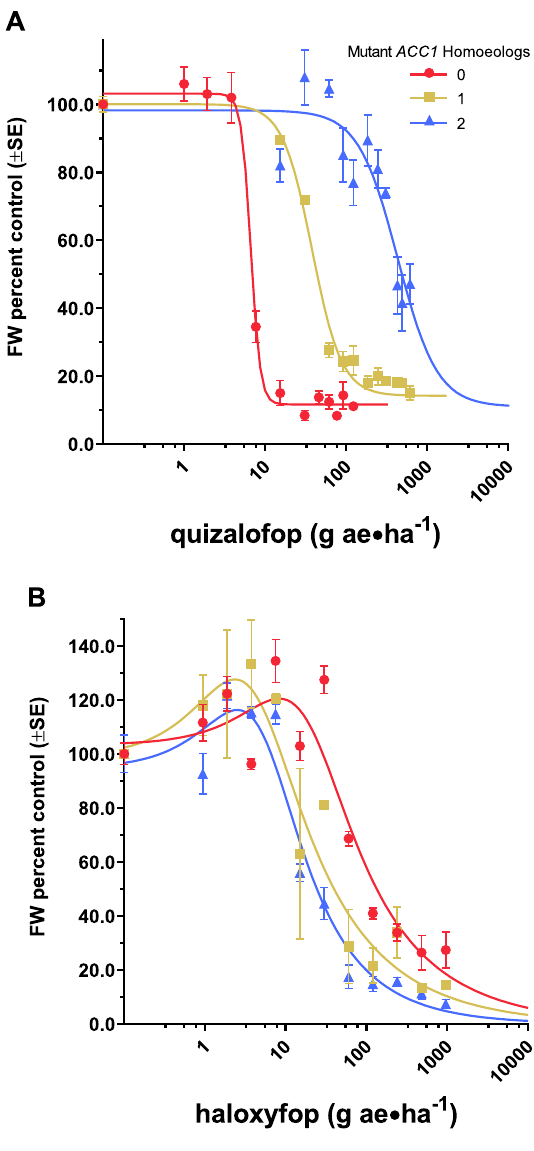
Figure 1. Models a of quizalofop ( A ) and haloxyfop ( B ) herbicide dose effects on whole-plant growth by genotype b . a Leaf fresh weight values (g) normalized to percent untreated controls and transformed with Box-Cox transformation per genotype for each herbicide. Quizalofop dose effect modeled with a 2-parameter log-logistic function ( A ) and haloxyfop dose effect modeled with a 4-parameter Brain-Cousens function ( B ). b Genotype refers to the number of homozygous mutations in ACC1 that result in a A2004V amino acid substitution, with up to three possible on group 2 chromosomes in hexaploid wheat (2n = 6x). These mutations result in quizalofop-resistant wheat